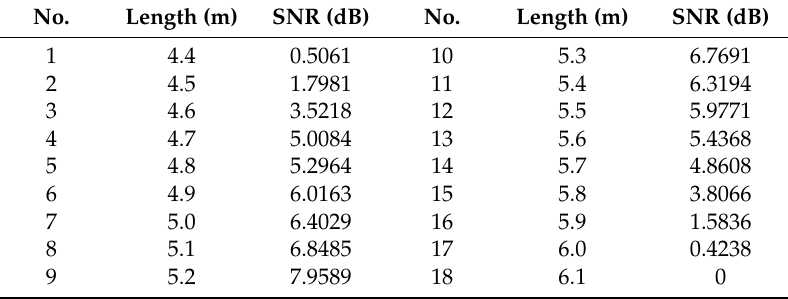
Table 1. Signal-to-noise ratio (SNR) at each point of the length axis.